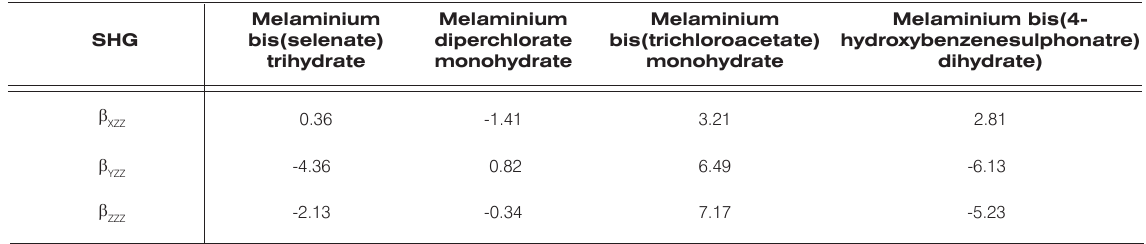
Table 4. The calculated second hyperpolarizability g (unit of g is 10 -36 esu) and its directional properties for investigated